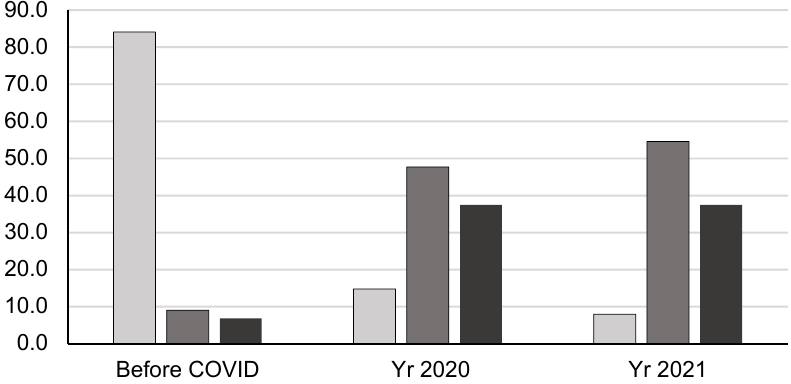
Figure 2. The respondents’ normal workplace for most of their working days before and during the COVID-19 pandemic.